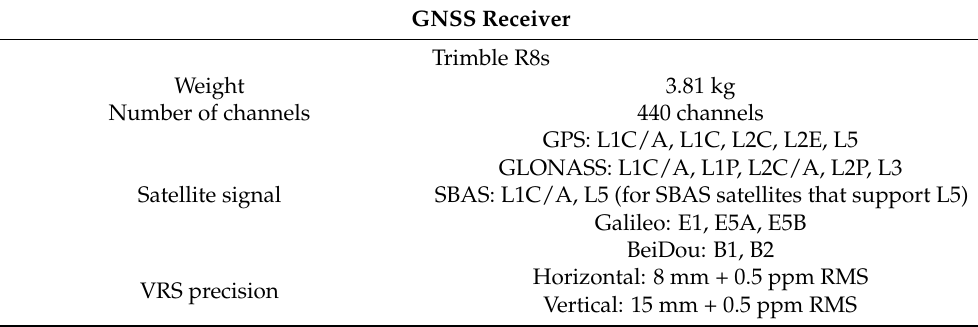
Table 2. Specifications of the Trimble R8s